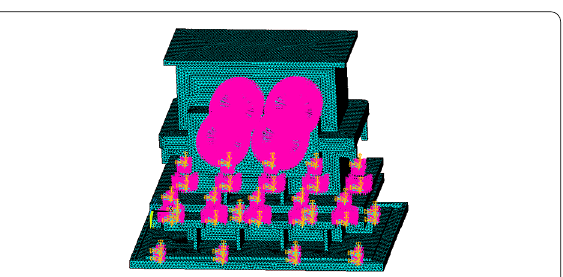
Figure 3 Finite element model of gearbox